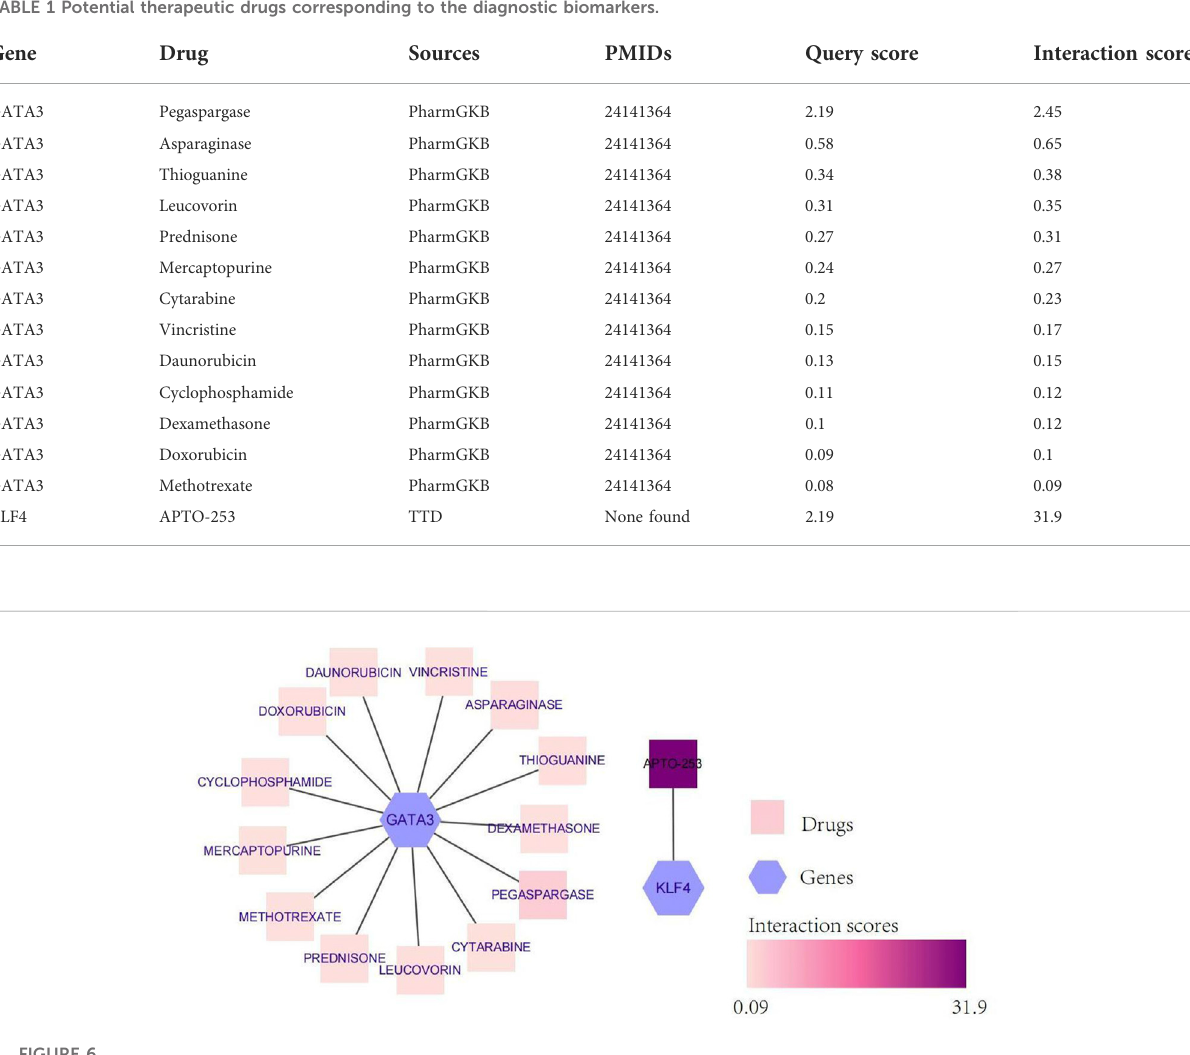
FIGURE 6 Network diagram of diagnostic biomarkers and potential therapeutic drugs. The hexagon indicates the biomarker, and the square indicates the potential therapeutic drug; the darker the potential therapeutic drug is, the higher the interaction